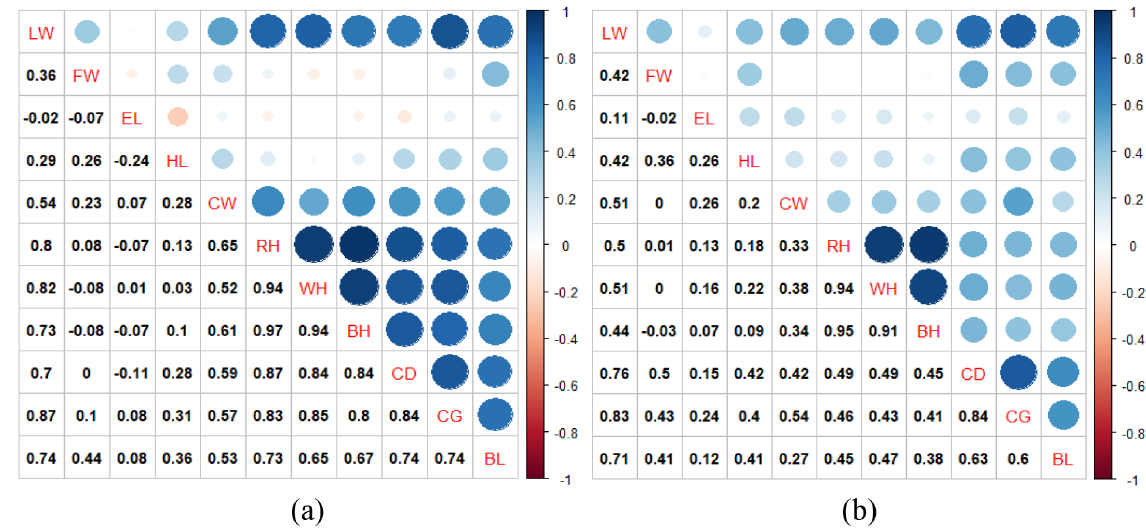
Figure 1. Pearson correlation coefficients between live weight and biometric body measurements for male (a) and female (b) goats.